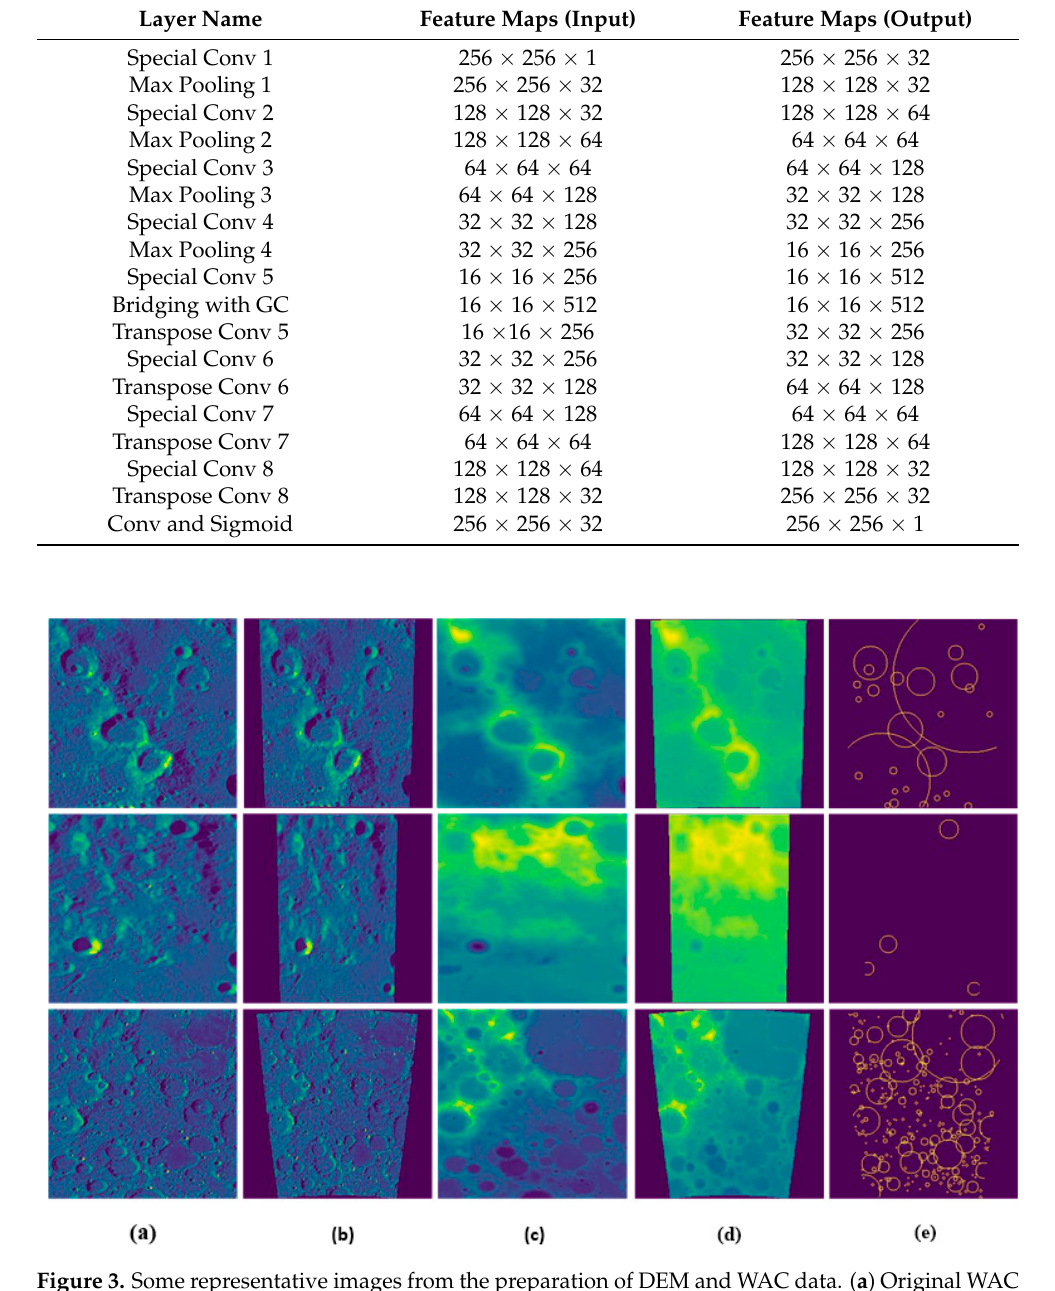
Table 2. Feature maps of the Dual-Path network structure.